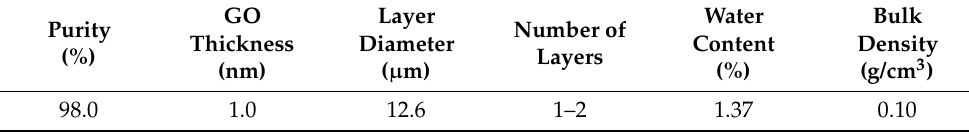
Table 2. Basic performance indexes of graphene